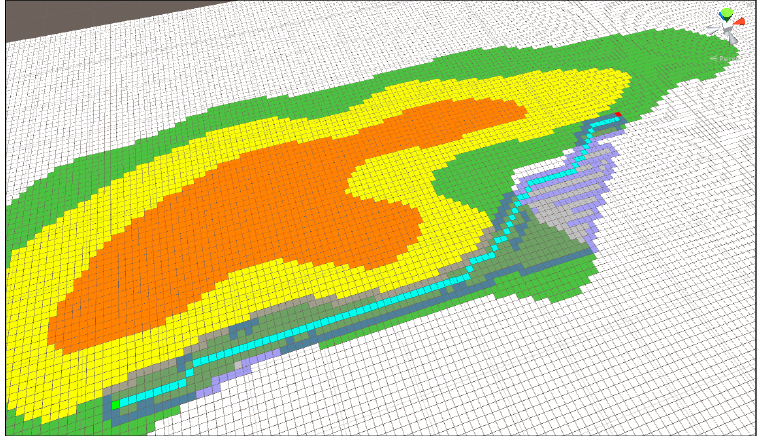
Figure 22. The route that takes the shortest distance using Dijkstra Algorithm (1).